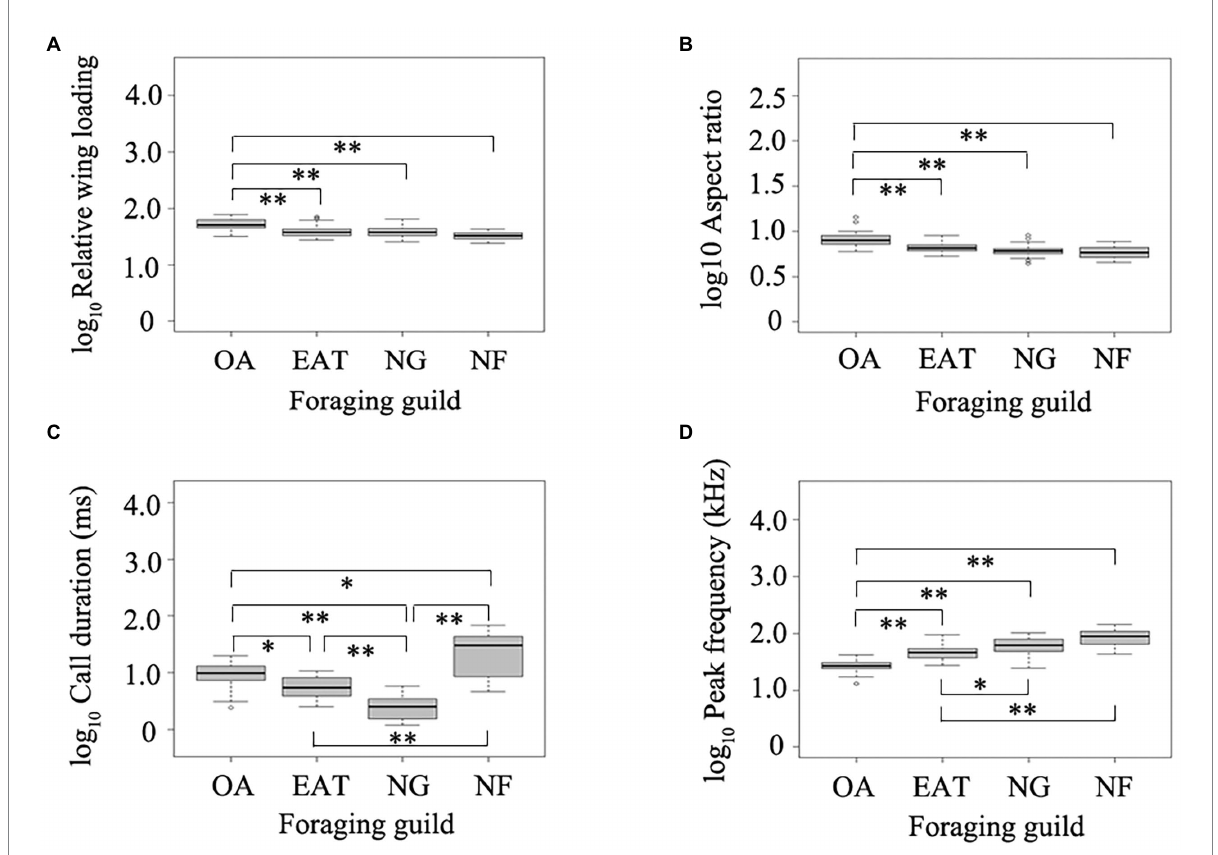
FIGURE 3 (A–D) Effects of foraging guilds on wing morphology and echolocation call parameters in bats. OA, open-space aerial forager; EAT, edge-space aerial and trawling forager; NG, narrow-space gleaning forager; NF, narrow-space flutter-detecting forager. Data in box plots represent the upper and lower adjacent values (highest and lowest horizontal line, respectively), 25 and 75% quartile with median value (box) and outliers (dots). Stars above and below boxplots indicate significant differences in pairwise comparisons between different foraging guilds based on phylogenetic analysis of variance. * p < 0.05. ** p <